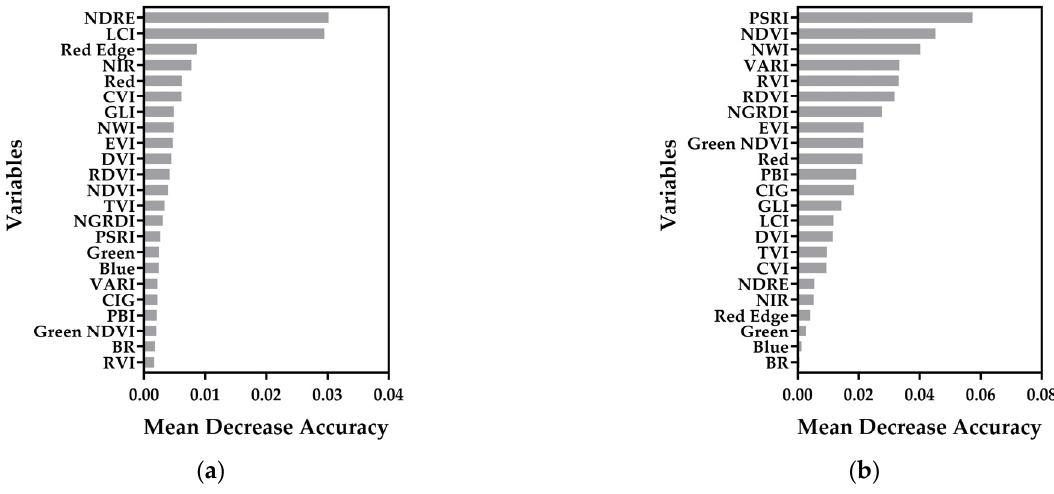
Figure 7. Parameter importance ranking ( a ) 23 July; ( b ) 24 August.